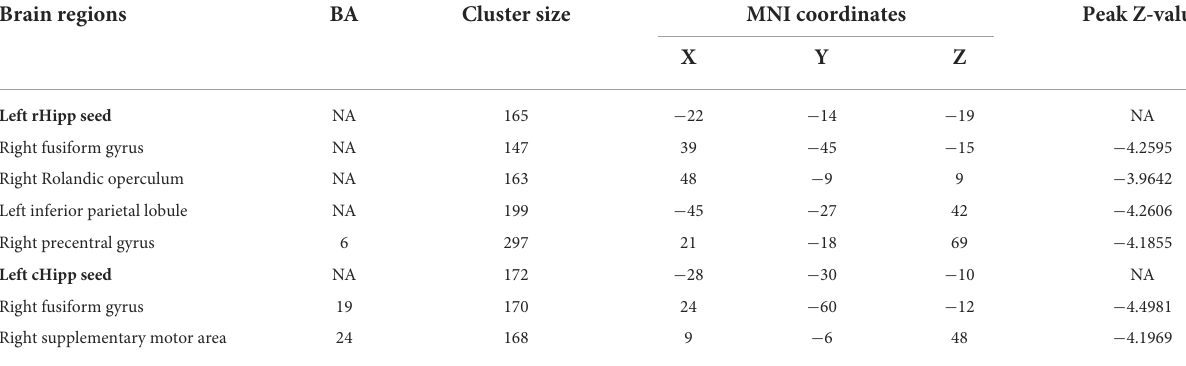
TABLE 2 Brain regions presenting significant differences in functional connectivity with left hippocampus between PNE and HC children (GRF corrected for single-voxel P < 0.001 and cluster-level P < 0.05). Brain regions BA Cluster size MNI coordinates Peak Z-value X Y